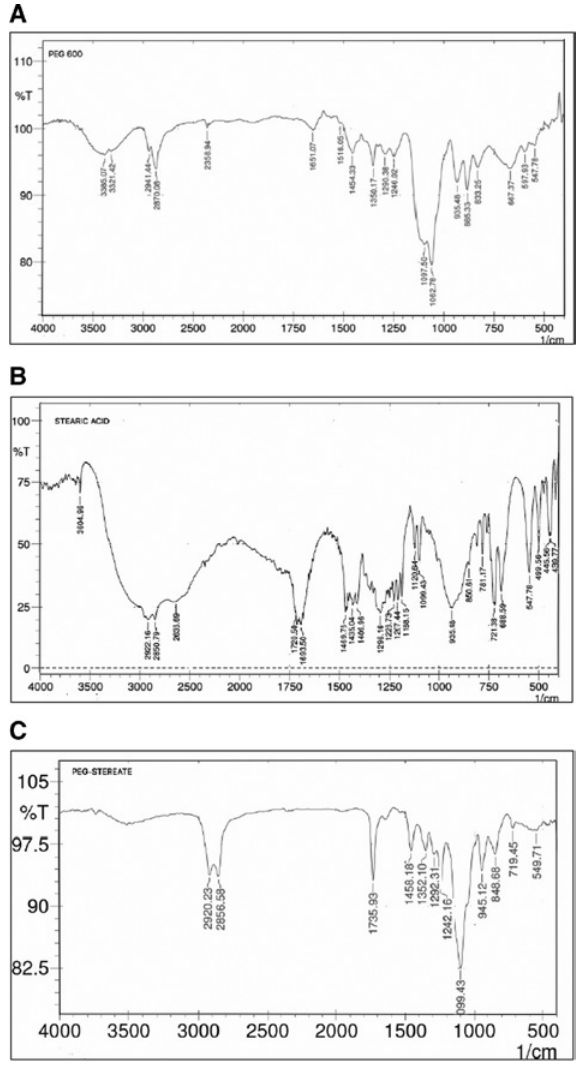
Figure 7: FT-IR spectra obtained before and after reaction between parent alcohol (A) PEG600 and acid (B) PEG600 and product (C) PEG stearate.